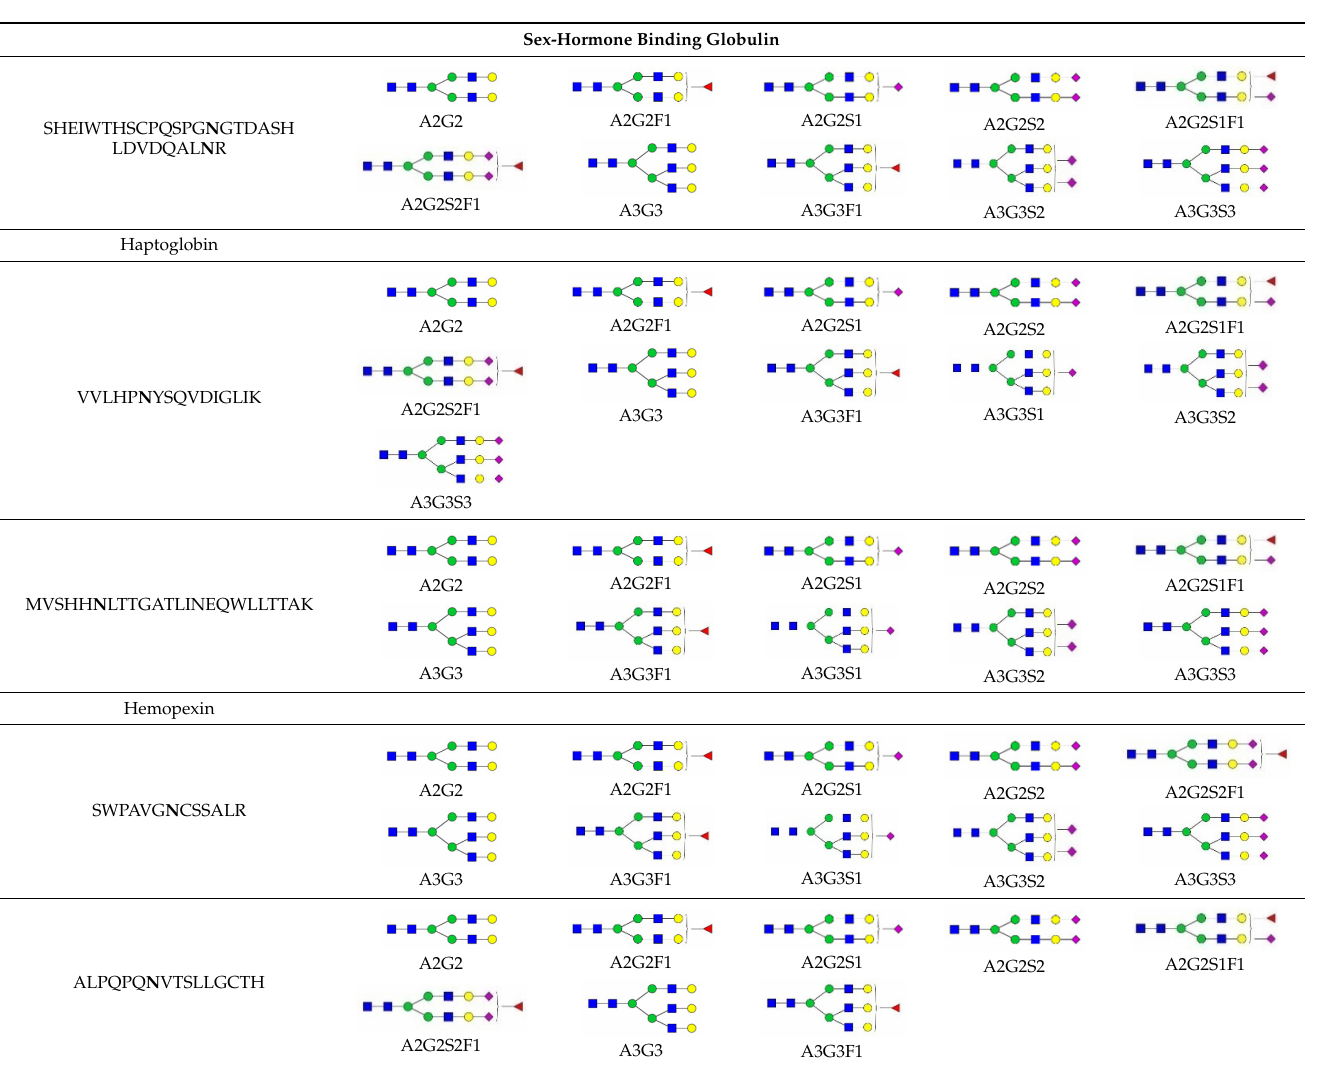
Table 1. The glycopeptides of sex hormone-binding globulin, haptoglobin, and hemopexin used to predict retention time windows. Symbols: , N -acetylglucosamine (GlcNAc); , Mannose (Man); , Galactose (Gal); , Fucose (Fuc); , Sialic